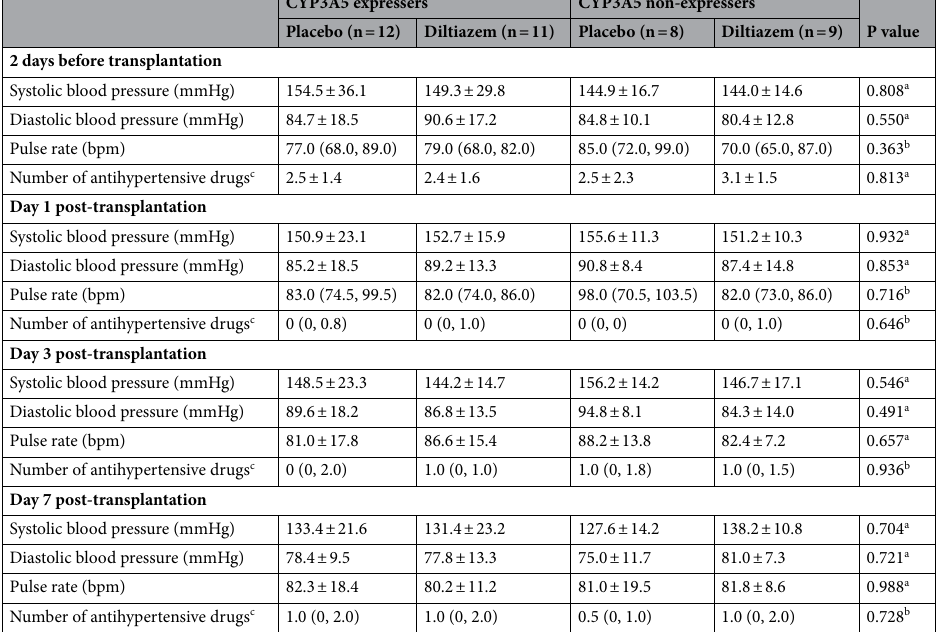
Table 5. Blood pressures, pulse rate, and number of antihypertensive medication use. Values are expressed as mean ± SD or median (interquartile range) for comparison reasons. a Analysis of variance. b Kruskal–Wallis test. c Not include diltiazem.